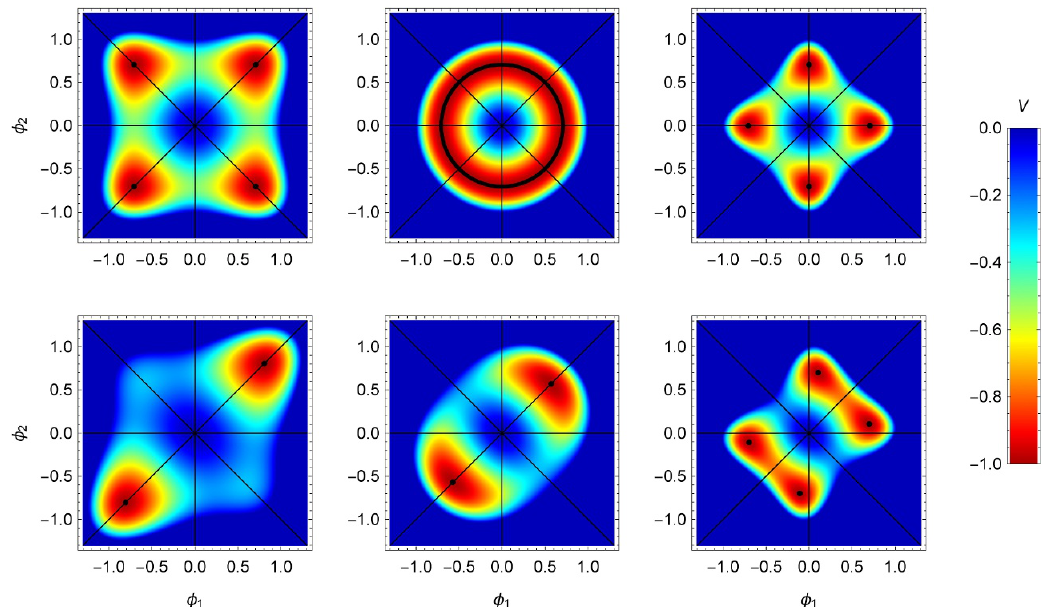
Figure 2 . Vacua in the D 4 -symmetric (upper panels) and D 4 -broken (lower panels) potentials. The D 4 -symmetric potential is given by eq. (4.4) with (cid:21) 3 = (cid:22) 2 = (cid:21) 1 = 1. The D 4 -broken potential is obtained by adding 1 This changes the locations of stable vacua (marked in black). The potentials are normalized so that V min = (cid:0)